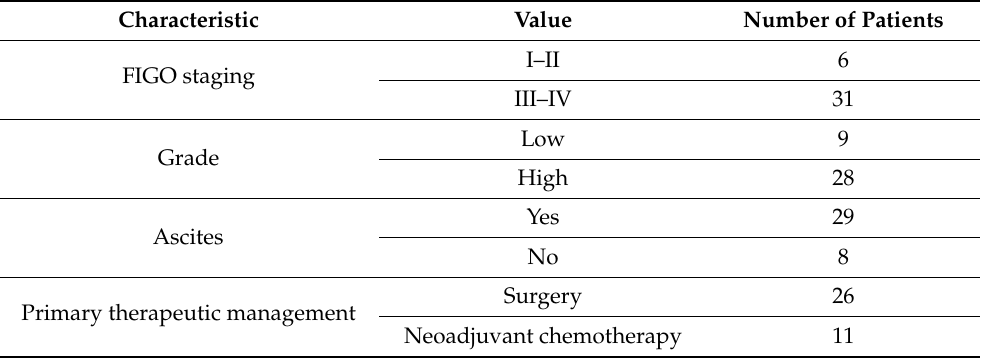
Table 1. Clinicopathological characteristics for the enrolled ovarian cancer patients. Characteristic Value Number of Patients FIGO staging